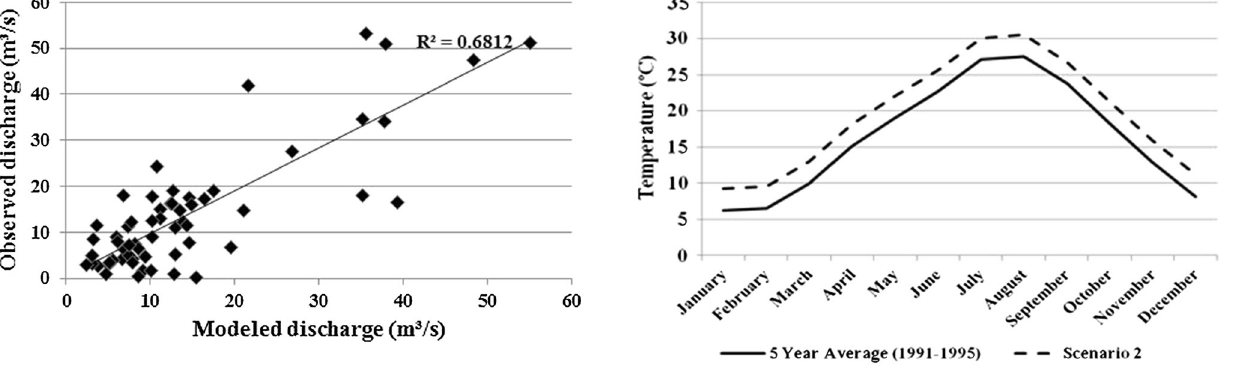
Fig. 9 Temperature change pattern after 100